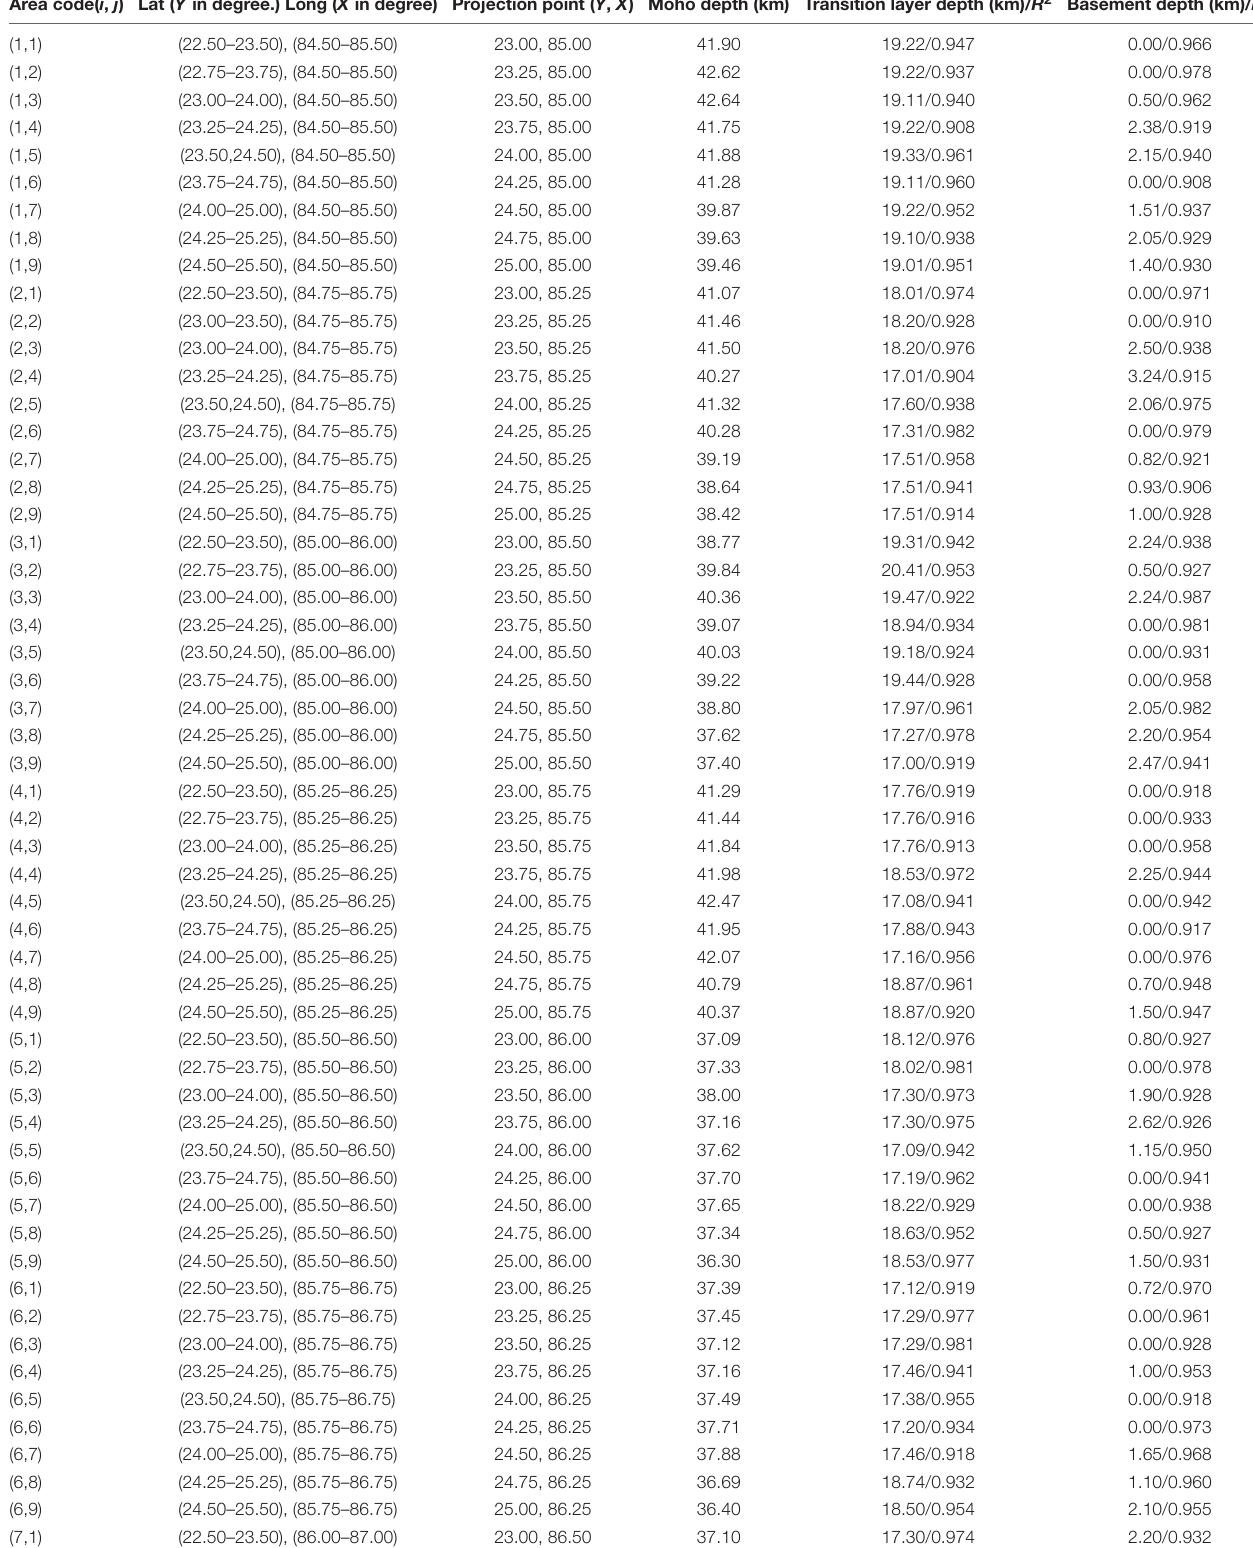
TABLE 3 | Ninety-nine blocks of 1 ◦ × 1 ◦ grid, with a 75% overlap with the adjacent grid for basement and Conrad depth calculation. Area code( i , j ) Lat ( Y in degree.) Long ( X in degree) Projection point ( Y , X ) Moho depth (km) Transition layer depth (km)/ R 2 Basement depth (km)/ R